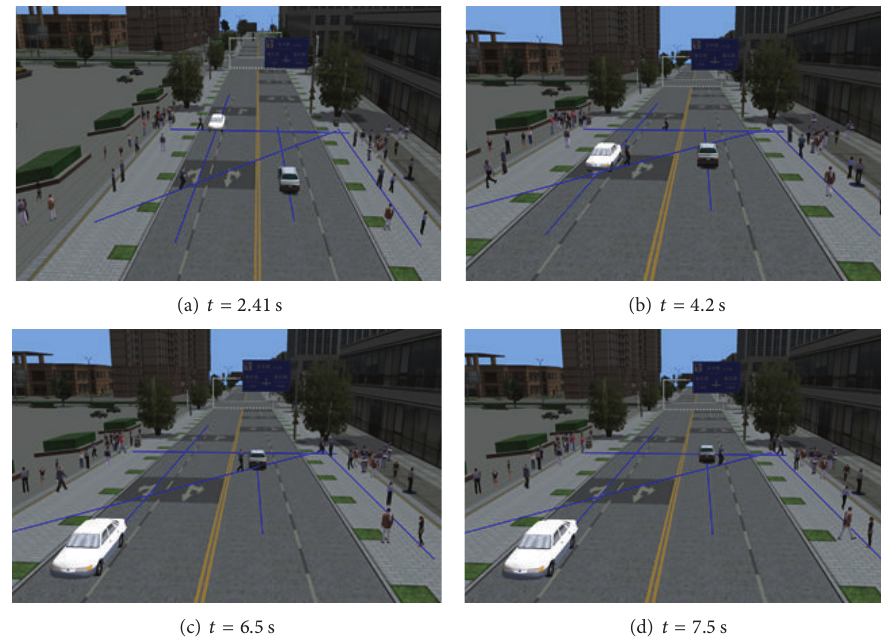
Figure 9: Visualization simulation results of the crowd